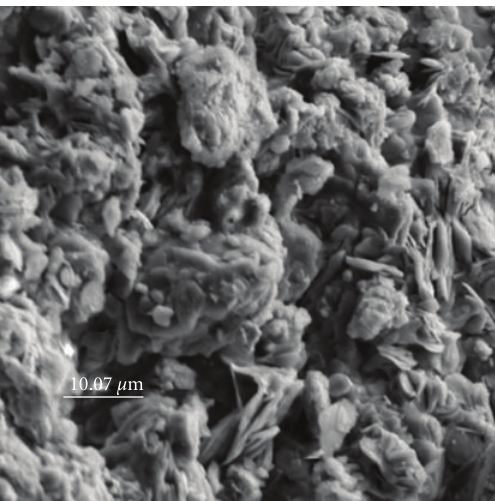
Figure 11: SEM micrograph showing the surface texture of a sand- size EAF slag particle (magnification =